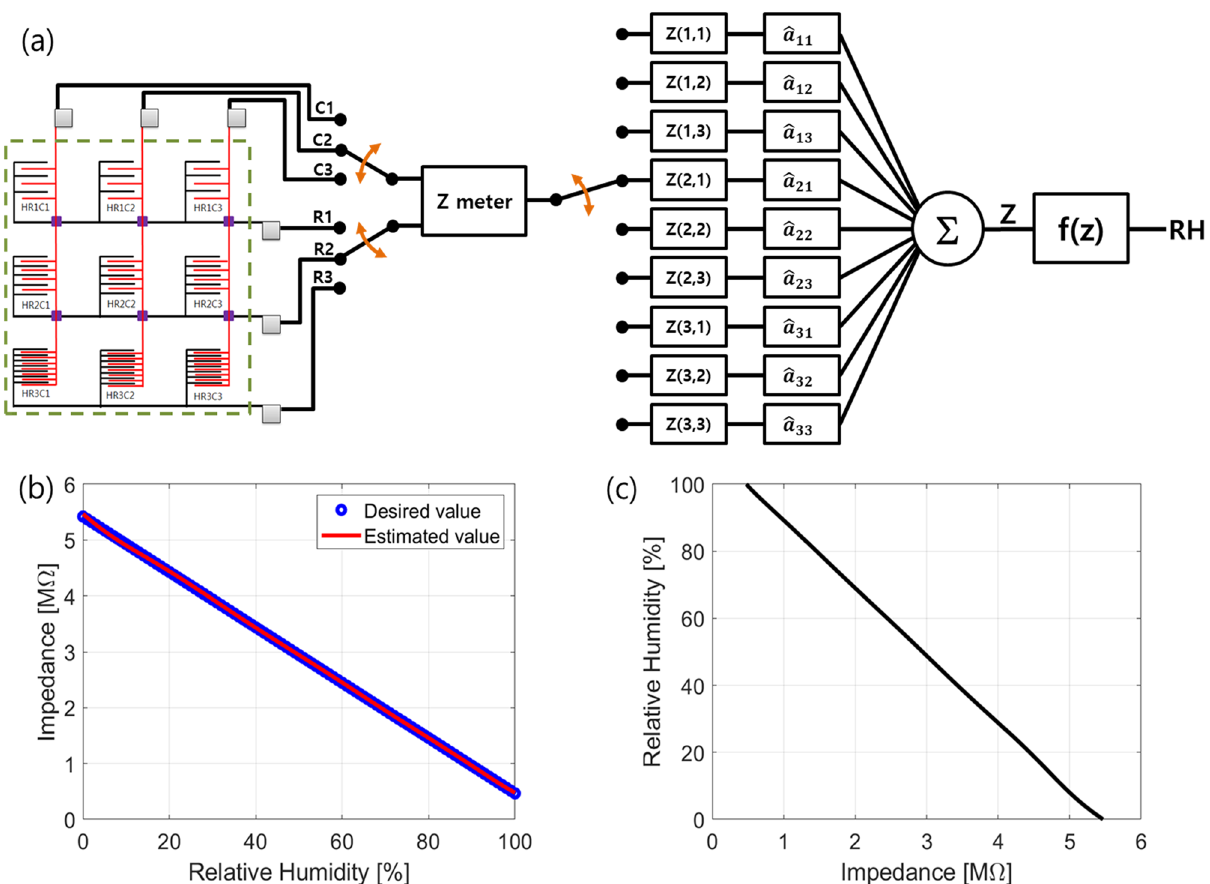
Figure 4. ( a ) Schematic diagram to find an RH value from the measured data of the proposed sensor array. ( b ) For all range linear function, comparison the ideal linear curve and the plotted estimated function by using the calculated estimate weight values ( ˆ a ) in Figure S8 of the supplementary information. ( c ) f(z) to find relative